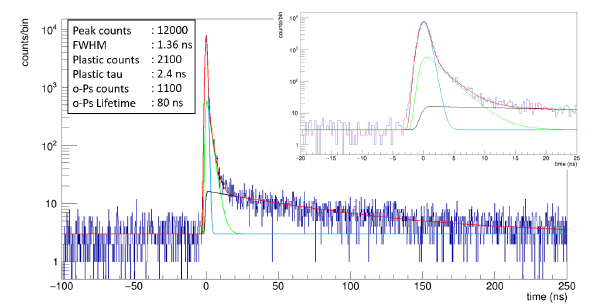
Figure 2. Demonstration of Positronium formation. Early